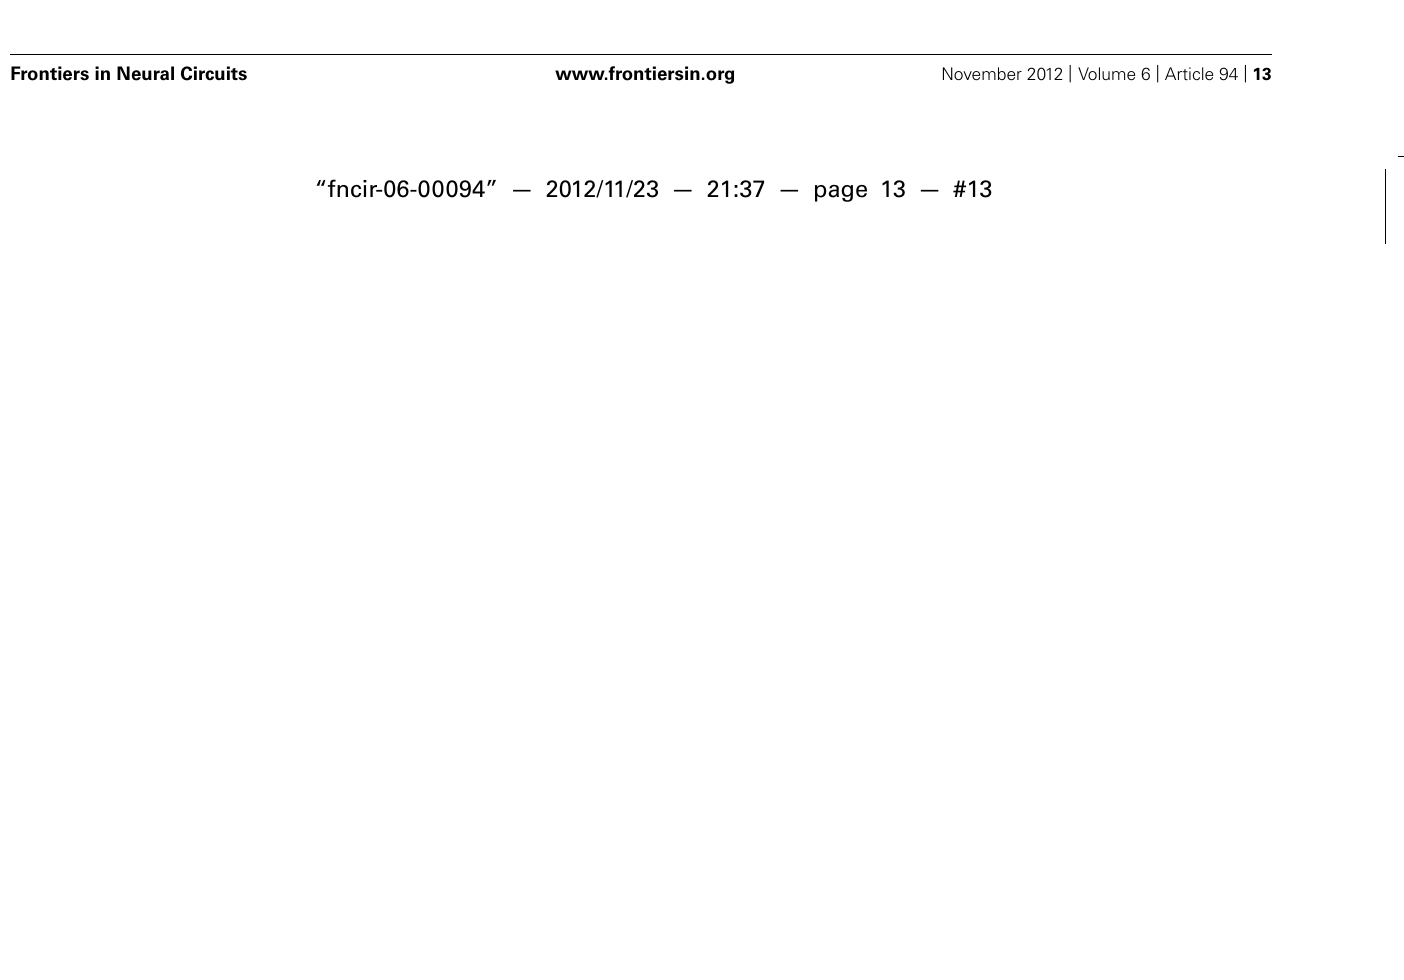
Notice that the LTD effect on the inhibitory neuron cluster is still present after MDZ application and this is evident also after CLZ on both clusters. Only the excitability of the excitatory cluster of neurons recovered from MDZ, back to control values. (B) Plots of cFSH data of excitatory (red) and inhibitory (black) neuron clusters in control, after FIN + MDZ (left) or FIN + CLZ (right) and after wash-out. Notice that the superimposed thin lines indicate control data for comparison. Upper and lower panels are related to states 1 and 2,